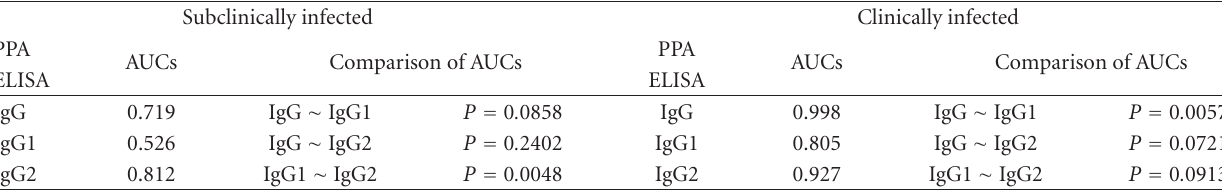
Table 2: Performances of isotypes/PPA-ELISAs for subclinically infected and clinically infected cattle.